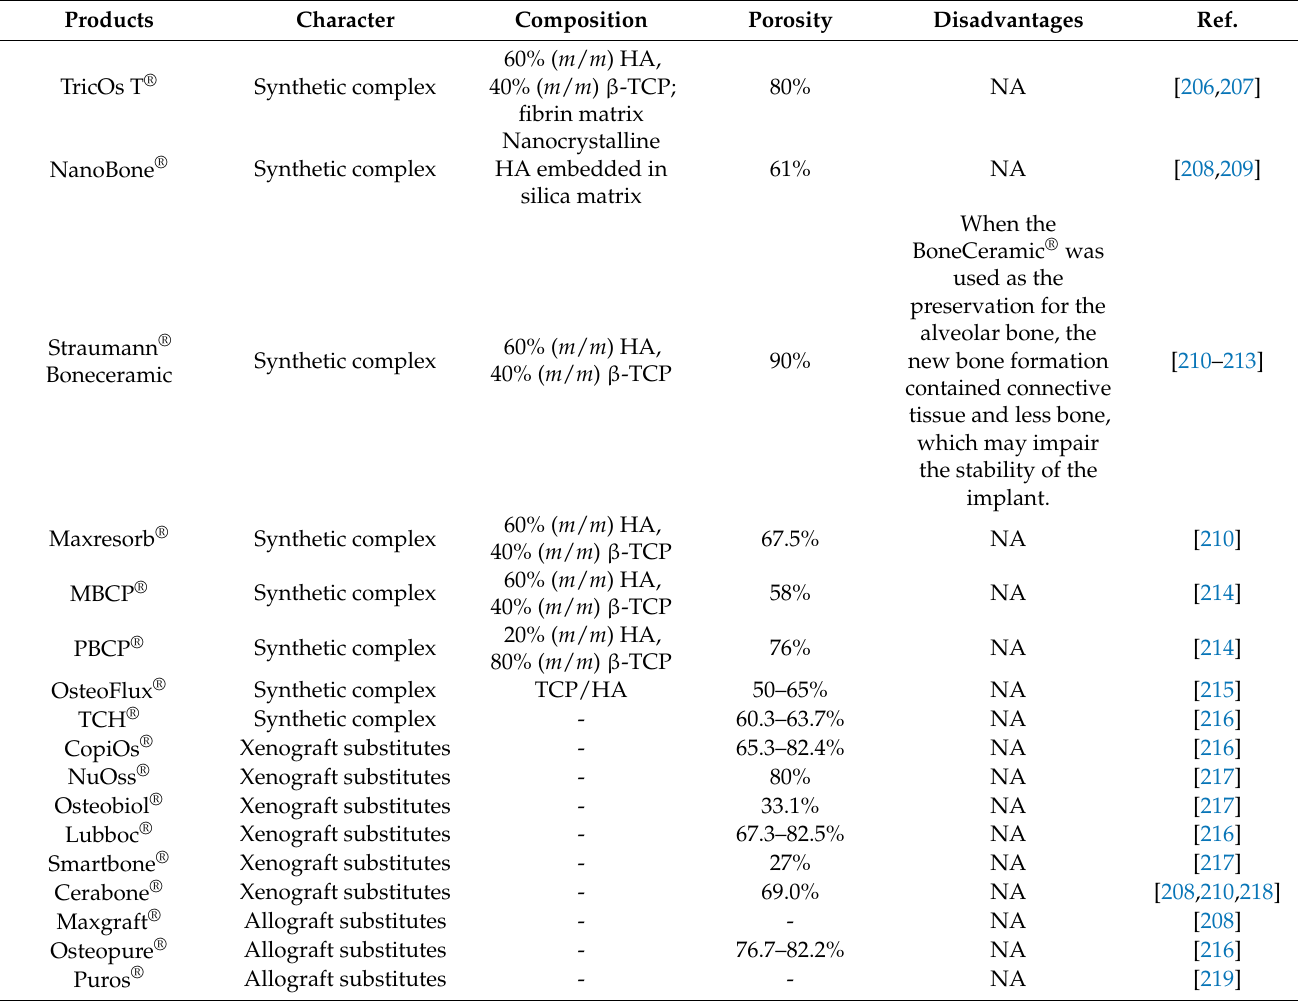
Table 4. The name, character, and composition of some HA composite